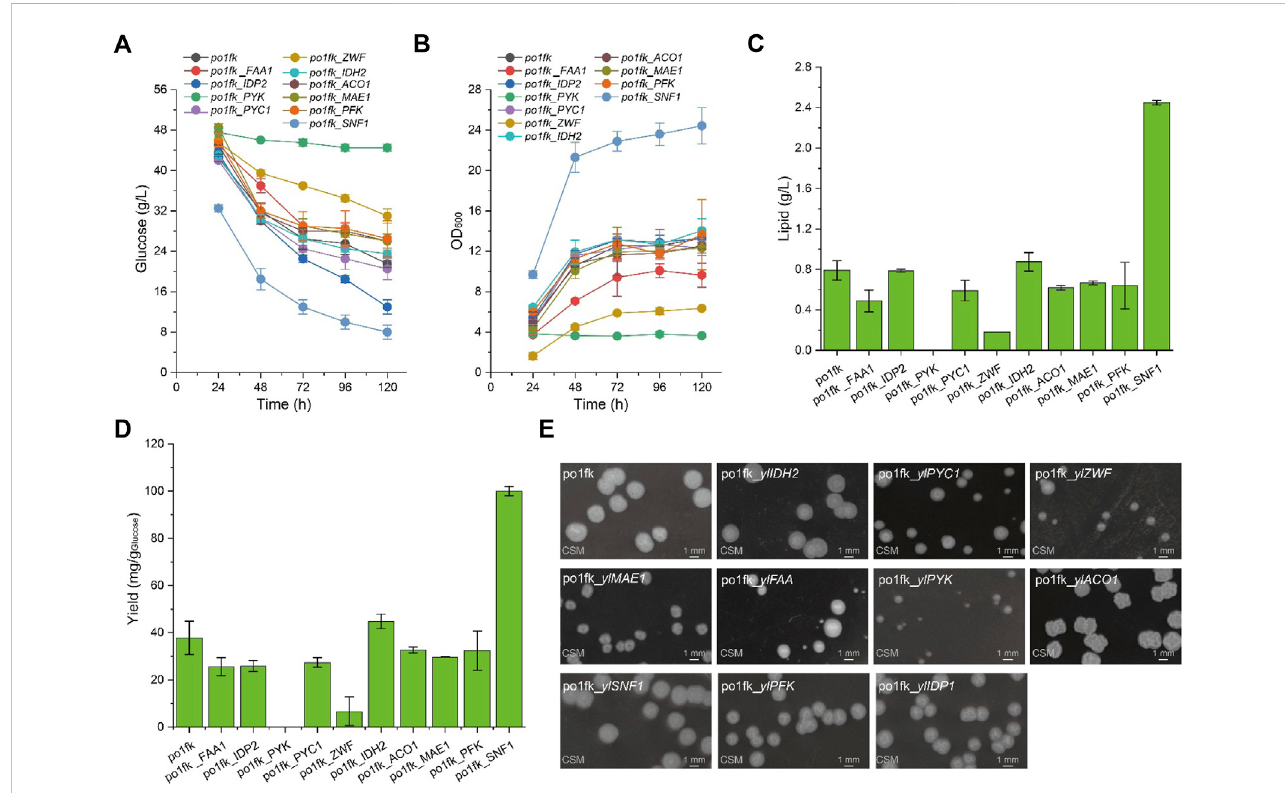
FIGURE 2 Time pro fi les of cell growth, glucose consumption, lipid titer and lipid yield in the CSM-leu medium and the morphology analysis of gene knockout strains. (A) Glucose consumption of po1fk, po1fk_ylPYK, po1fk_ylACO1, po1fk_ylPFK, po1fk_ylSNF1, po1fk_ylIDP2, po1fk_ylZWF, po1fk_ylIDH2, po1fk_ylMAE, po1fk_ylPYC1, andpo1fk_ylFAA; (B) Cell growth ofpo1fk,po1fk_ylPYK,po1fk_ylACO1,po1fk_ylPFK,po1fk_ylSNF1, po1fk_ylIDP2, po1fk_ylZWF,po1fk_ylIDH2, po1fk_ylMAE, po1fk_ylPYC1, and po1fk_ylFAA; (C) Lipid titer of po1fk, po1fk_ylPYK, po1fk_ylACO1, po1fk_ylPFK, po1fk_ylSNF1, po1fk_ylIDP2, po1fk_ ylZWF, po1fk_ylIDH2, po1fk_ylMAE, po1fk_ylPYC1, and po1fk_ylFAA; (D) Lipid yield of po1fk, po1fk_ylPYK, po1fk_ylACO1, po1fk_ylPFK, po1fk_ylSNF1, po1fk_ ylIDP2, po1fk_ylZWF, po1fk_ylIDH2, po1fk_ylMAE, po1fk_ylPYC1, and po1fk_ylFAA; (E) the morphology analysis of gene knockout strains. For analyzing